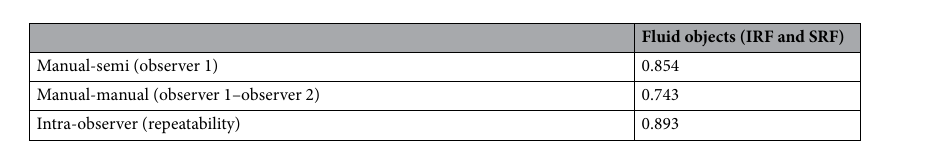
Table 4. Dice coefficients for one grader’s manual and semi-automatic fluid localization and two graders’ manual localization as well as the intra-observer